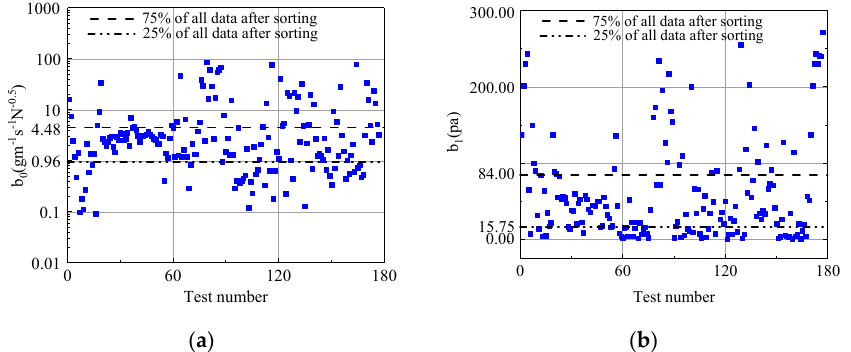
Figure 3. Erodibility parameters of the Wilson model: the erodibility parameters b 0 ( a ); the erodibility parameters b 1 ( b ).